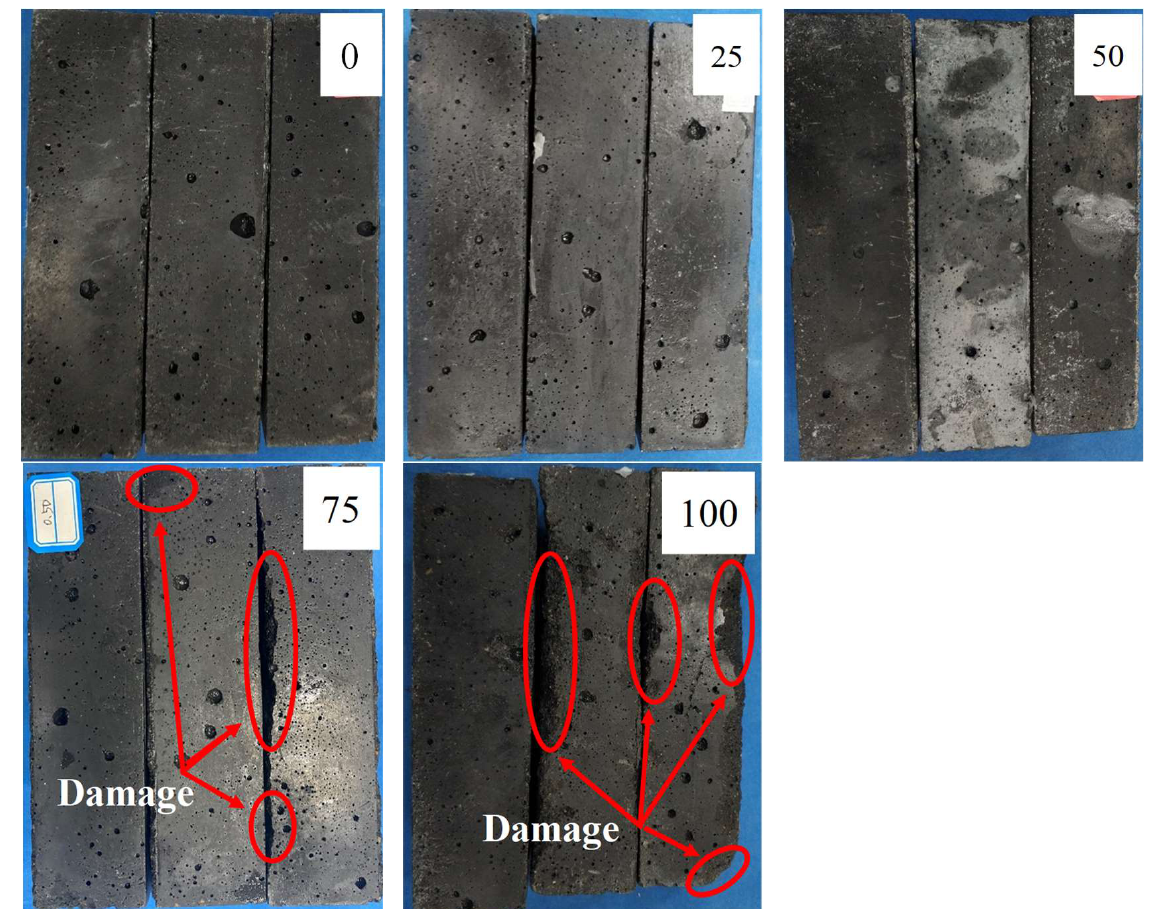
Figure 5. Appearance of the damage to the